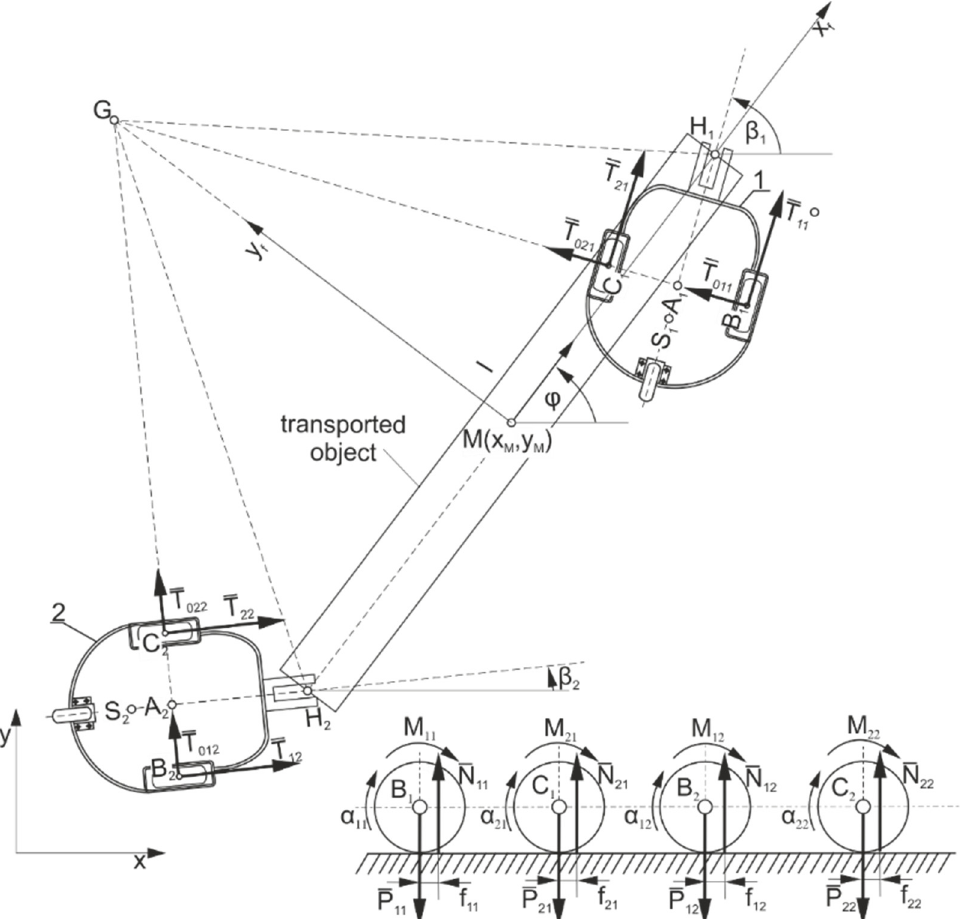
Figure 2. Distribution of external forces acting on the formation of robots.